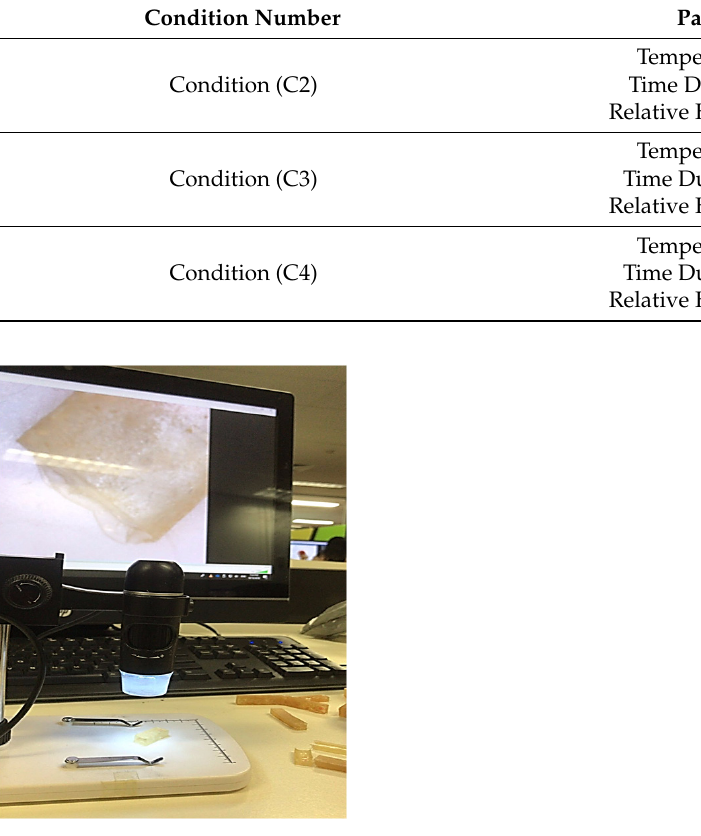
Figure 7. Microstructure Analysis (A Digitech ® 5MP USB Microscope Camera).